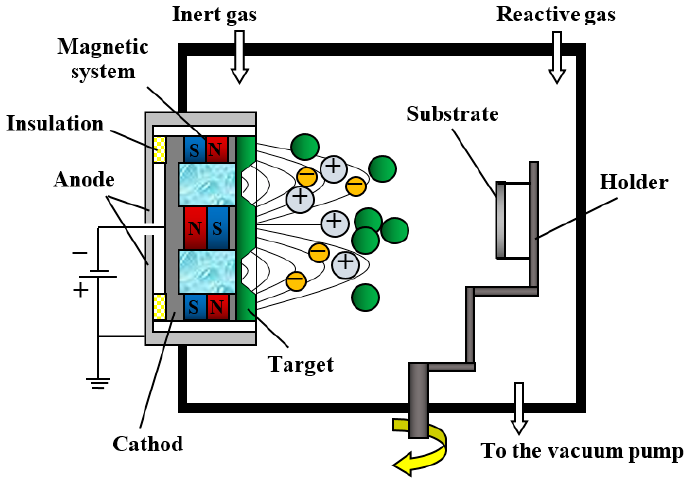
Figure 2. Schematic diagram of a magnetron sputtering system for producing dielectric coatings with the help of a reaction gas [15].